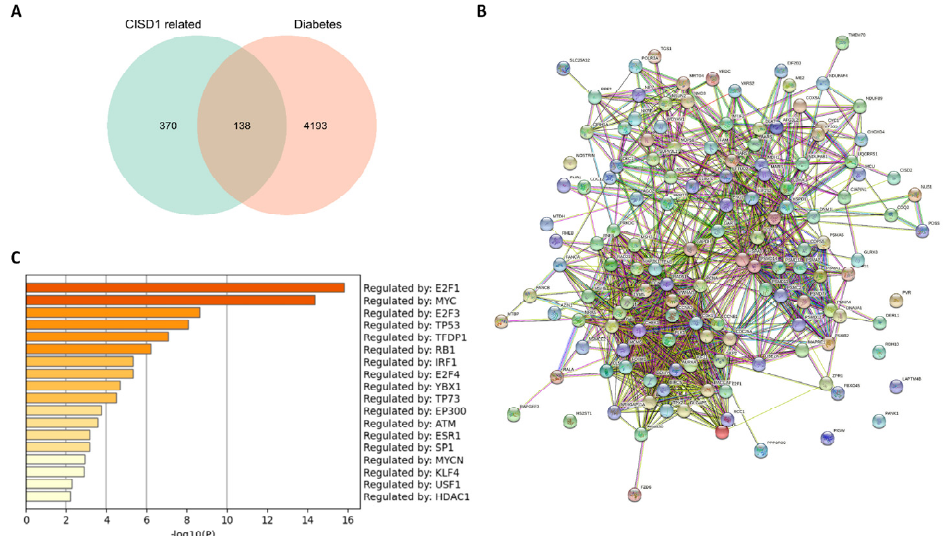
Figure 5. Shared genes between the co-expression genes with CISD1 and “diabetes mellitus”. A Venn diagram of shared genes between the co-expressed genes with CISD1 and “diabetes mellitus” ( A ); Protein-protein interaction network of the shared genes ( B ); and prediction of the transcription factors of the shared genes ( C ).